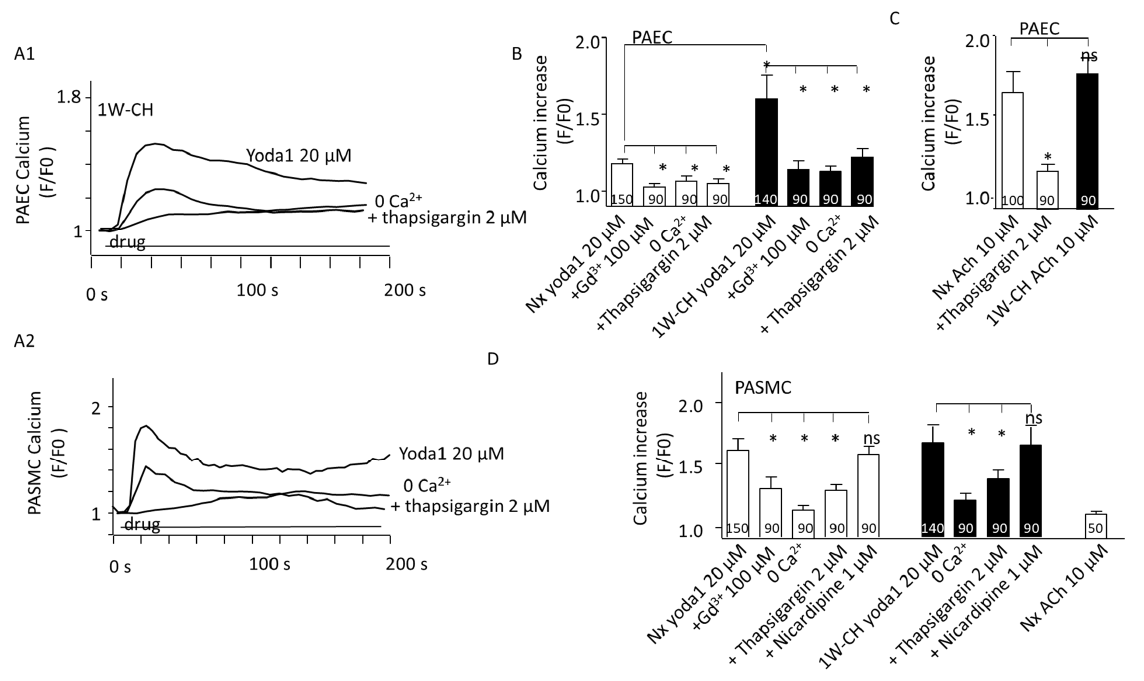
Figure 6. PAEC and PASMC Piezo1 current in an early stage of CH-PH. Piezo1 activation increased intracellular calcium concentration ([Ca 2+ ]i) in both PAECs and PASMCs. ( A1 ) Yoda1 (20 µ M) induced a sustained increase in Cal520 fluorescence in isolated PAECs from 1W-CH IPA that was reduced in presence of thapsigargin (2 µ M) or in absence of extracellular calcium (0 Ca 2+ ). ( A2 ) Typical trace of calcium increase recorded in the presence of Yoda1 in Nx PASMCs that was reduced in presence of thapsigargin (2 µ M) or in absence of extracellular calcium (0 Ca 2+ ). ( B ) Statistical analysis of